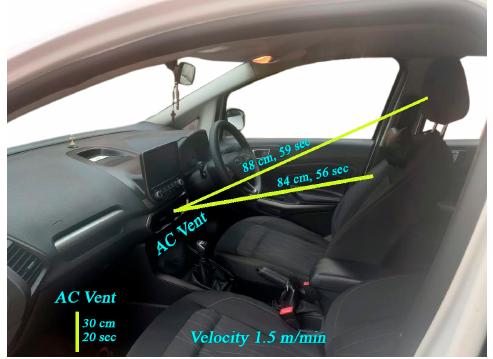
Figure 12. Age of